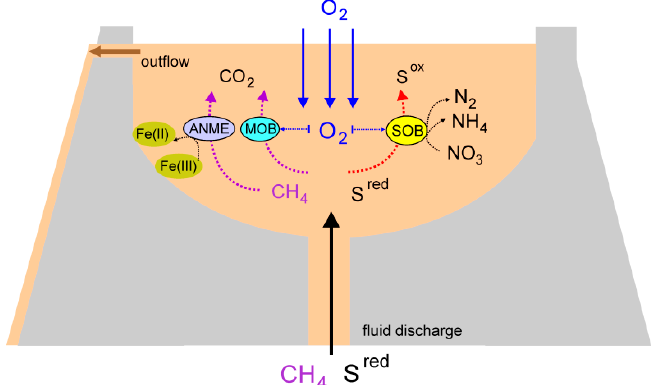
Figure 4. Microbial processes related to sulfur and methane cycling in the mud volcano. SOB, bacteria performing aerobic and/or anaerobic oxidation of sulfur compounds; MOB, aerobic methanotrophic bacteria.